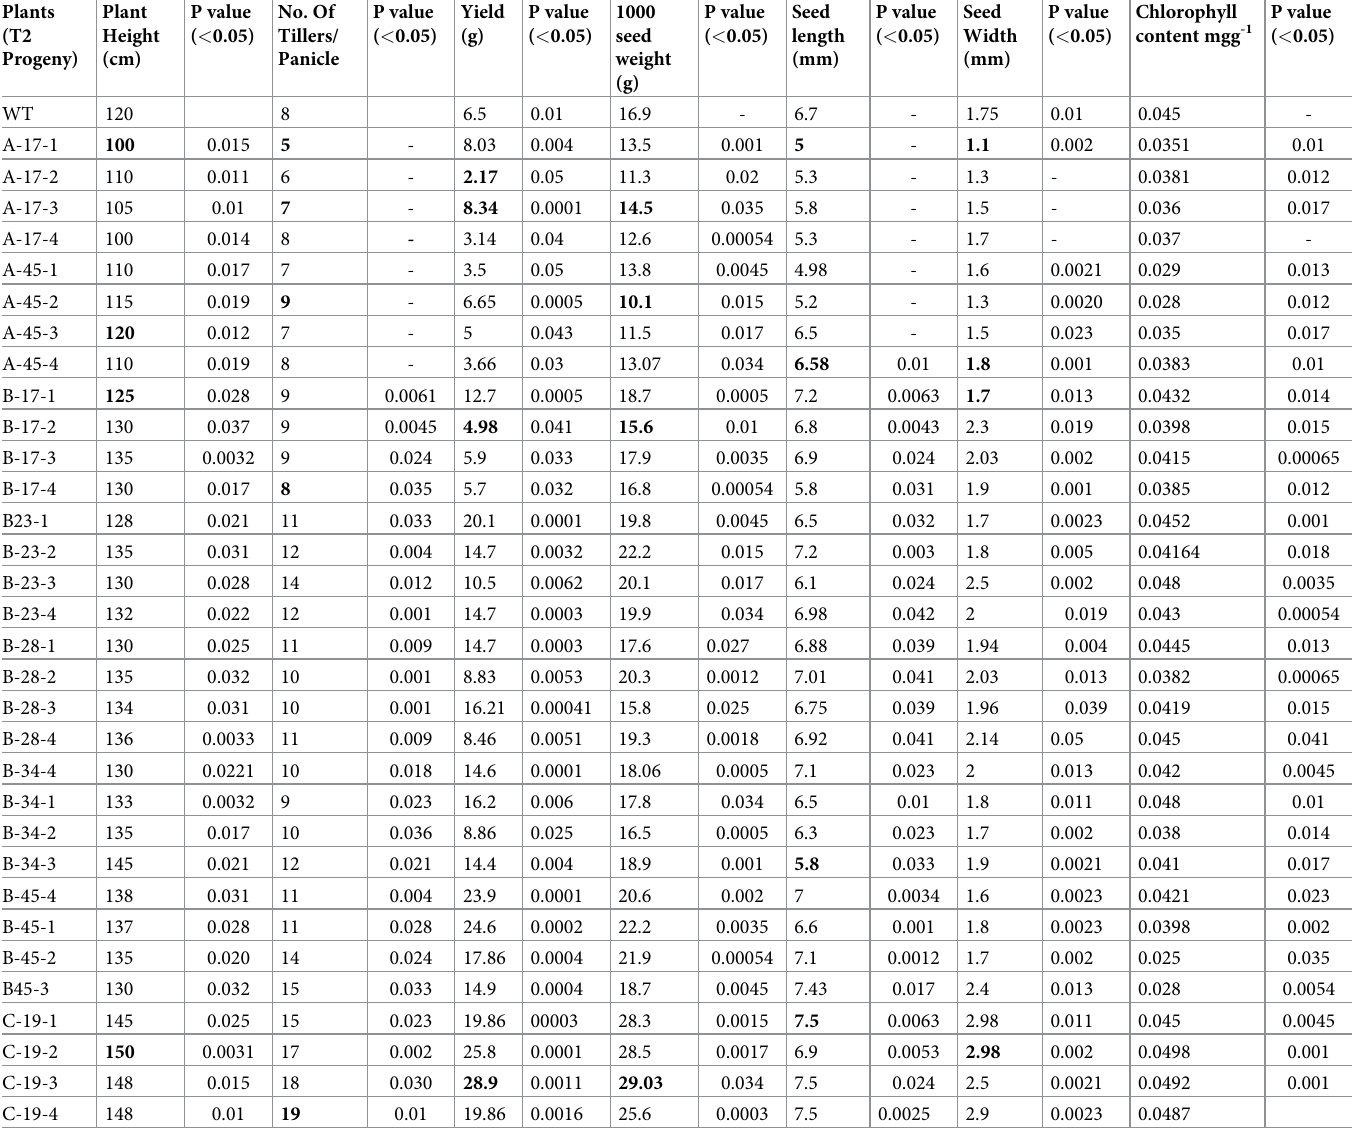
Table 4. Morphological characterization of T2 transgenic progeny plants with statistical analysis (student’s t-test). Plants